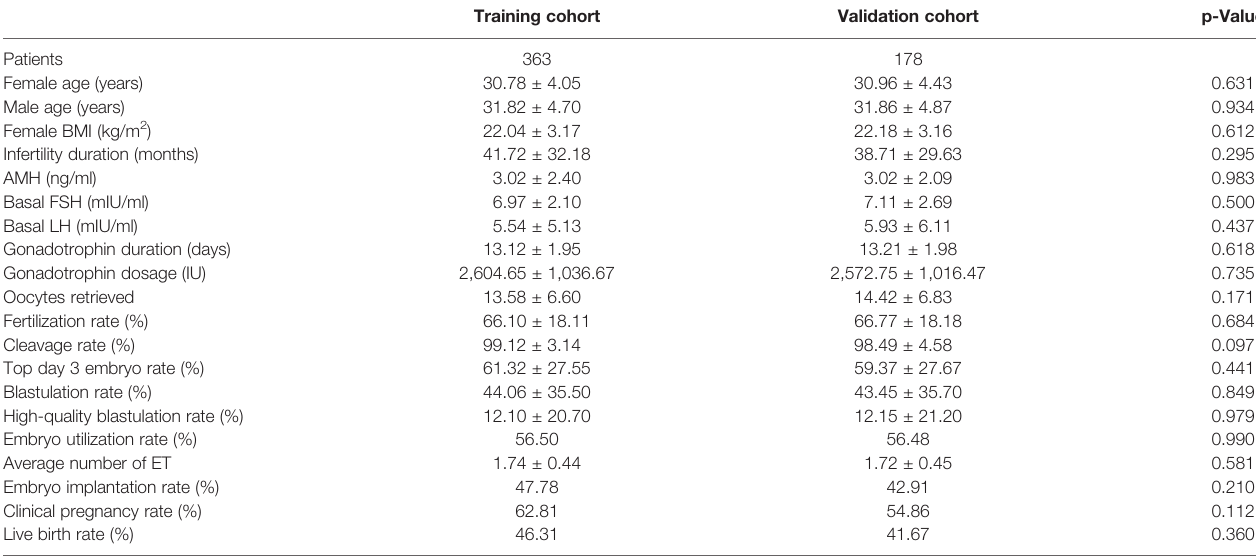
TABLE 3 | Characteristics of endometriosis group in the training and validation cohorts.